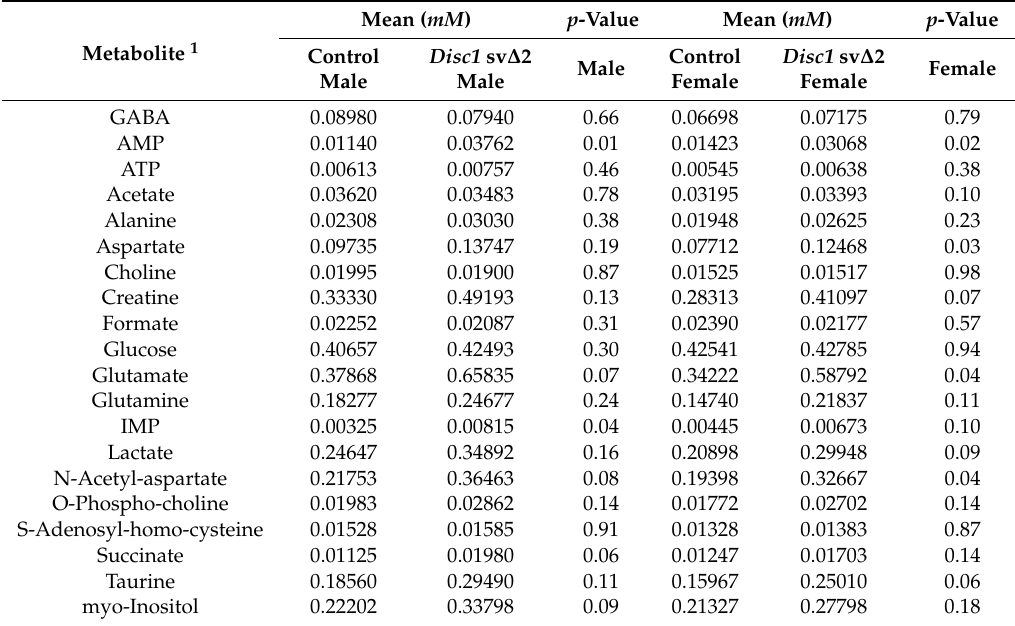
Table 2. Disc1 sv ∆ 2 contributes to significant changes in metabolite concentrations in both male and female